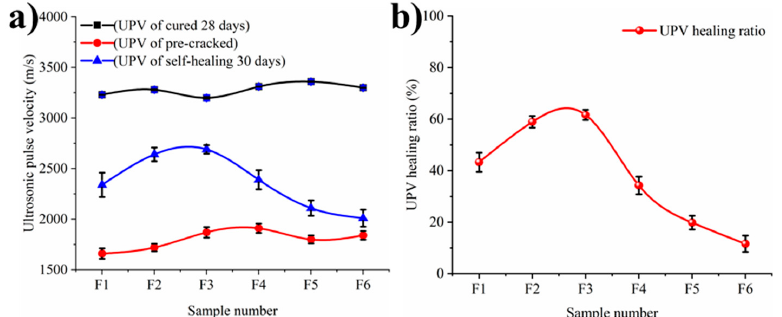
Figure 5. Ultrasonic pulse velocity of samples cured 28 days. ( a ): the UPV values of un-cracked, pre-cracked and self-healing samples, respectively; ( b ): the UPV healing rates.